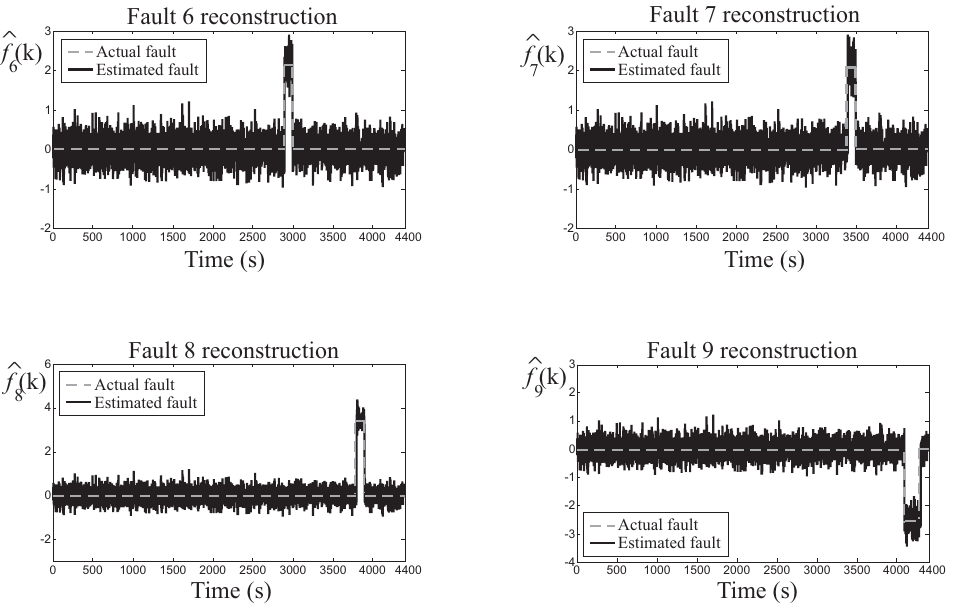
Figure 6. Estimated and actual faults for cases 6, 7, 8, and